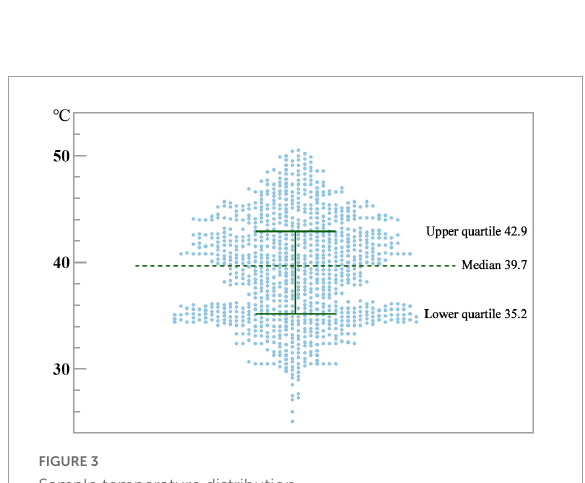
FIGURE3 Sample temperature